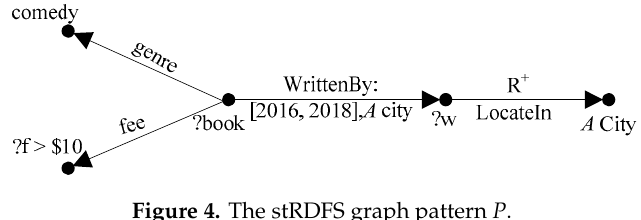
Figure 4. The stRDFS graph pattern P .